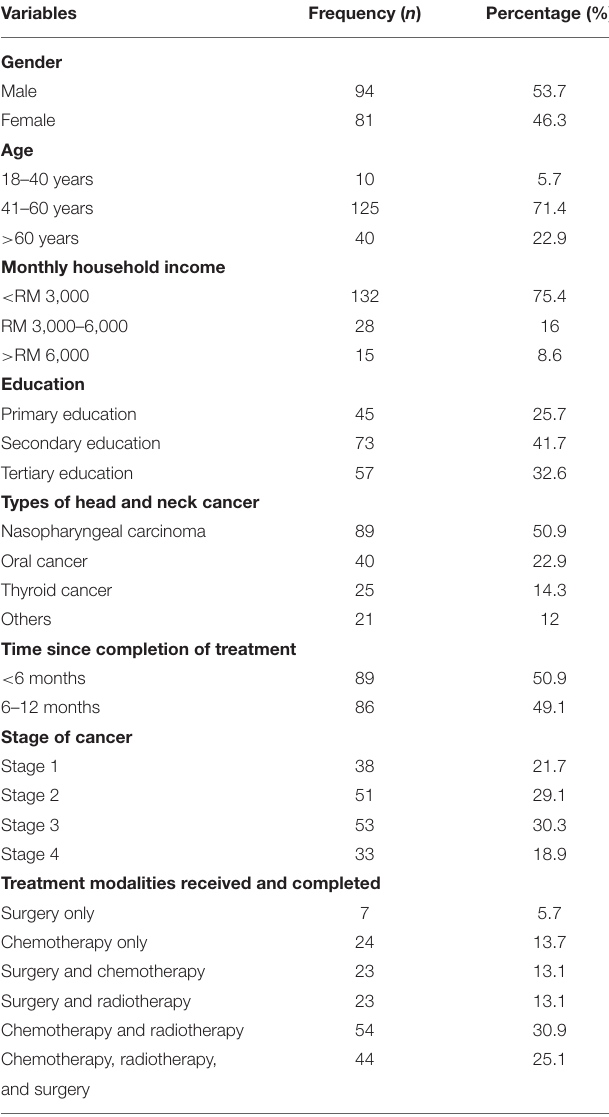
TABLE 1 | Socio-demographic and clinical characteristics of